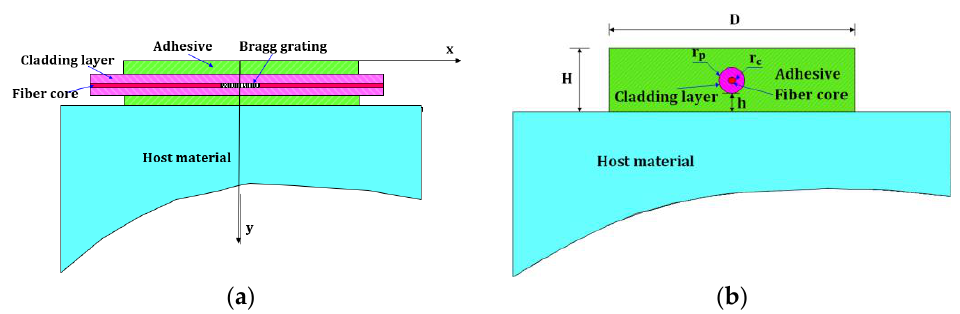
Figure 6. Schematic diagram of the sensor structure. ( a ) The main view of the schematic diagram; ( b ) the side view of the schematic diagram.